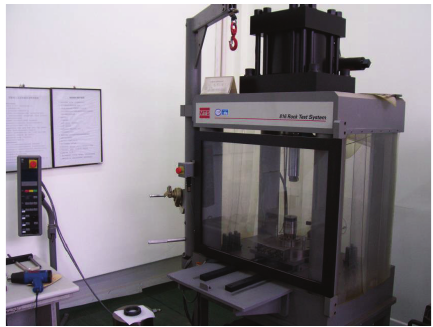
Figure 6: MTS-816 rock test